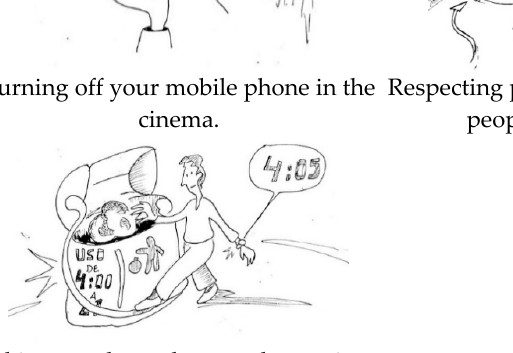
Figure A1. Civic pictures.